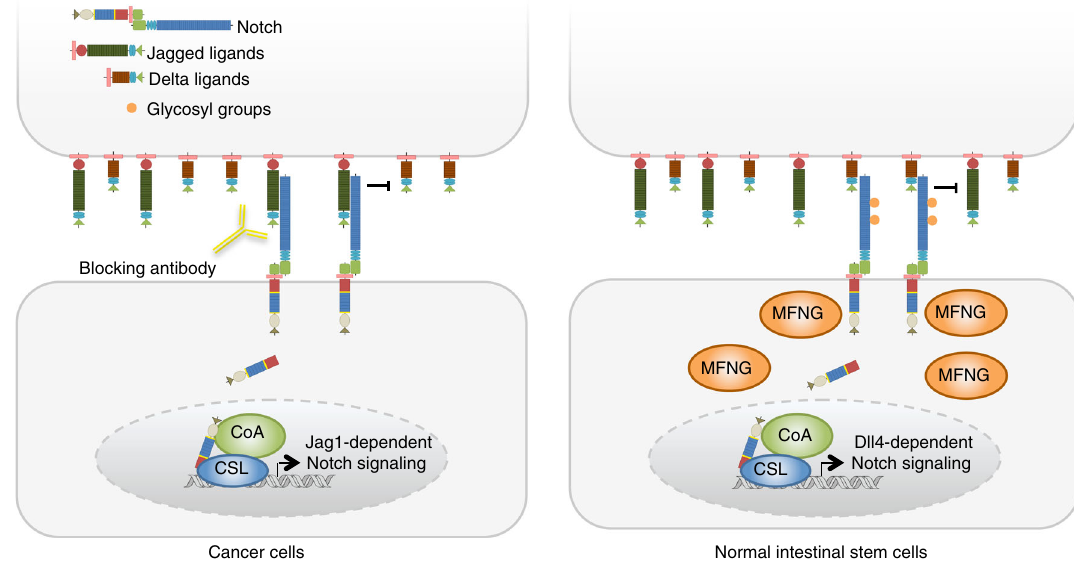
Fig. 7 Model representing the differential requirement for Jag1 in the normal and transformed intestinal epithelial cells. As shown in the fi gure, MFNG in normal intestinal stem cells glycosylate Notch1 thus favoring its activation mediated by the Dll4 ligand that is localized in the adjacent (Paneth) cells. In contrast, non-glycosylated Notch1 present in the MFNG-negative tumor cells cannot respond to Dll4 leading to Jag1, which makes them addicted